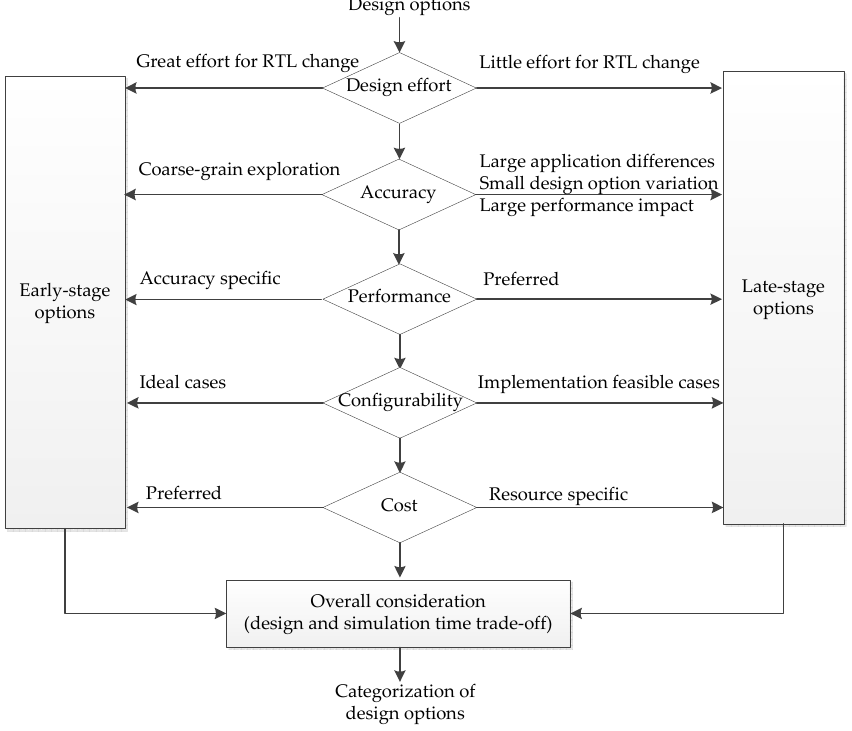
Figure 3. Categorization decision